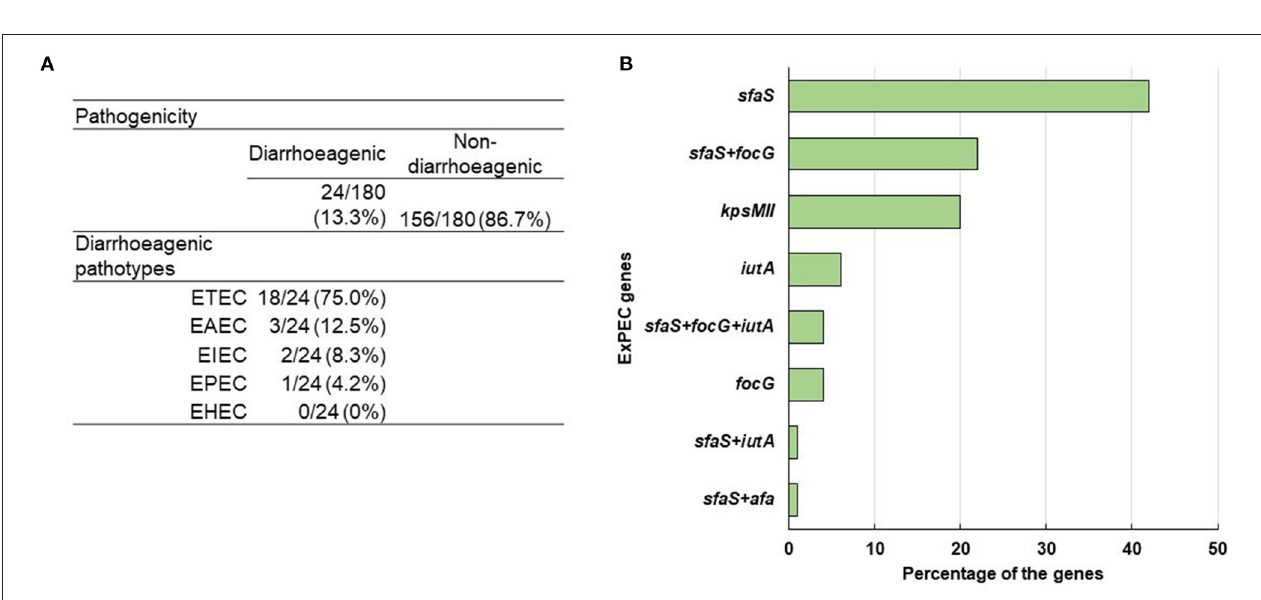
FIGURE 5 | (A) Distribution of diarrheagenic pathogens and different E. coli pathotypes. (B) Percentage of ExPEC genes among the positive isolates.